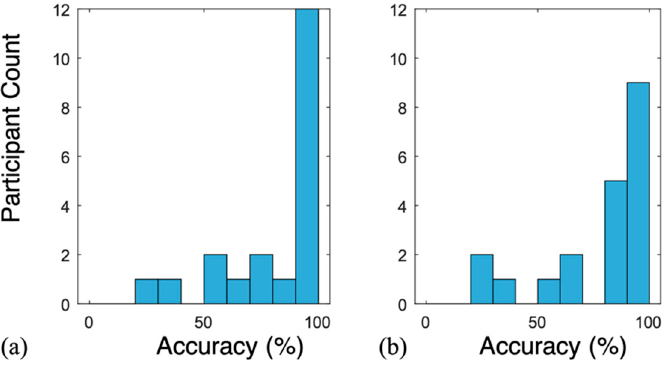
Figure 7. Test accuracy distribution across the participants using the personal calibration model by ( a ) NCS and ( b ) the reference. Table 3. Personalized prediction model performance across